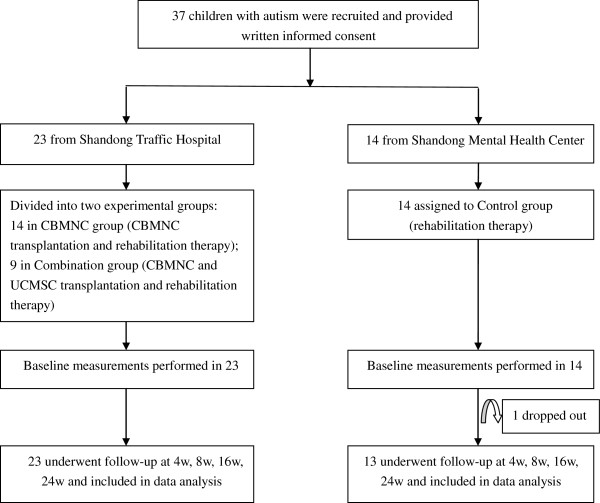
Enrollment and retention algorithm.